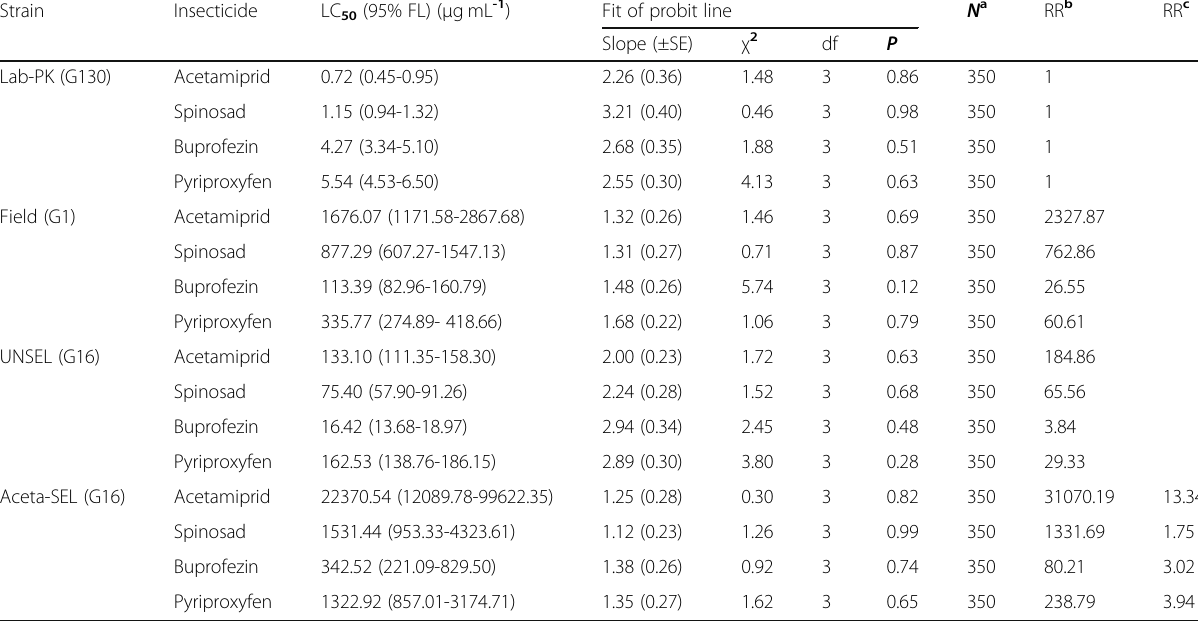
Table 1 Response of various insecticides to Lab-PK, Field, UNSEL and Aceta-SEL populations of Chrysoperla carnea